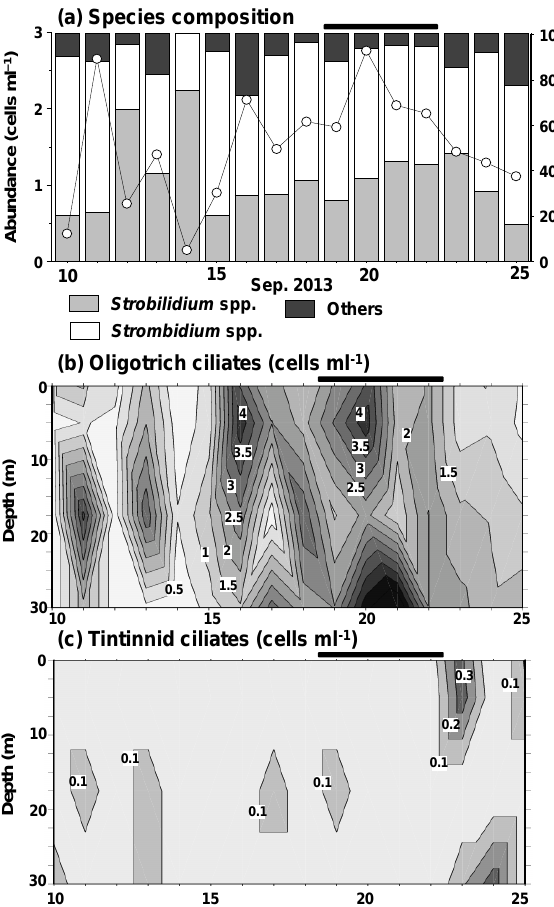
Figure 5. Temporal changes in cell density and species composi- tion of total ciliates (a) , the vertical distribution of oligotrich cili- ates (cellsmL − 1 ) (b) and tintinnid ciliates (cellsmL − 1 ) (c) in the Chukchi Sea during the period from 10 to 25 September 2013. In (a) , values represent the mean ciliate abundance between 0 and 30m. Solid bars indicate the timing of a strong wind event.